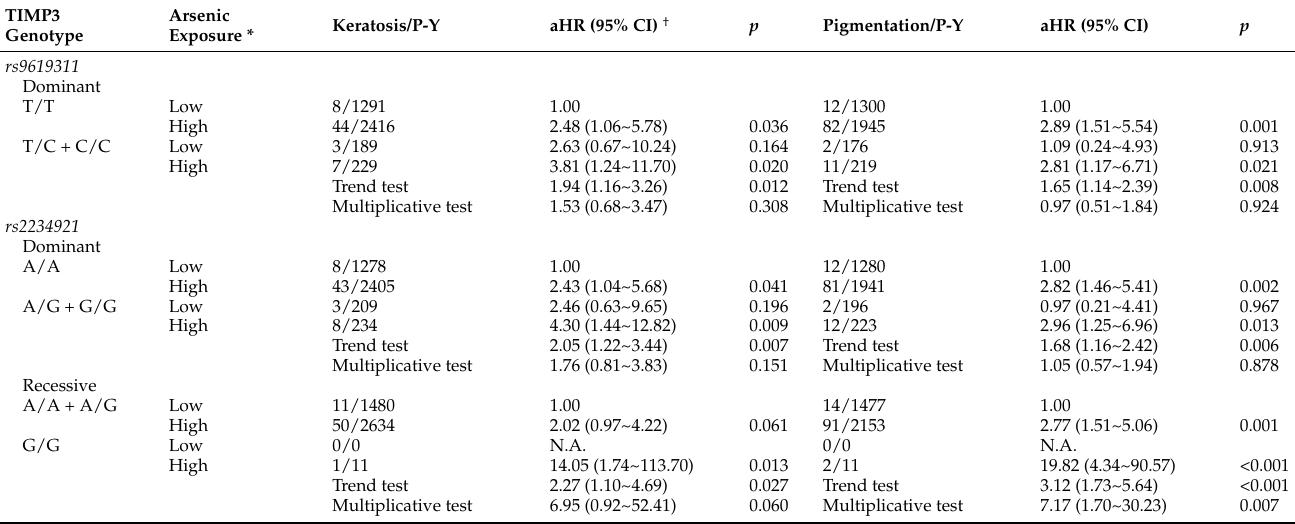
Table 6. Combined effect of the TIMP3 genotypes and arsenic exposure on the risk of skin hyperker- atosis and hyperpigmentation.